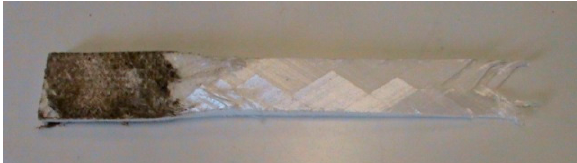
Figure 10. Failure of tension shear specimen.